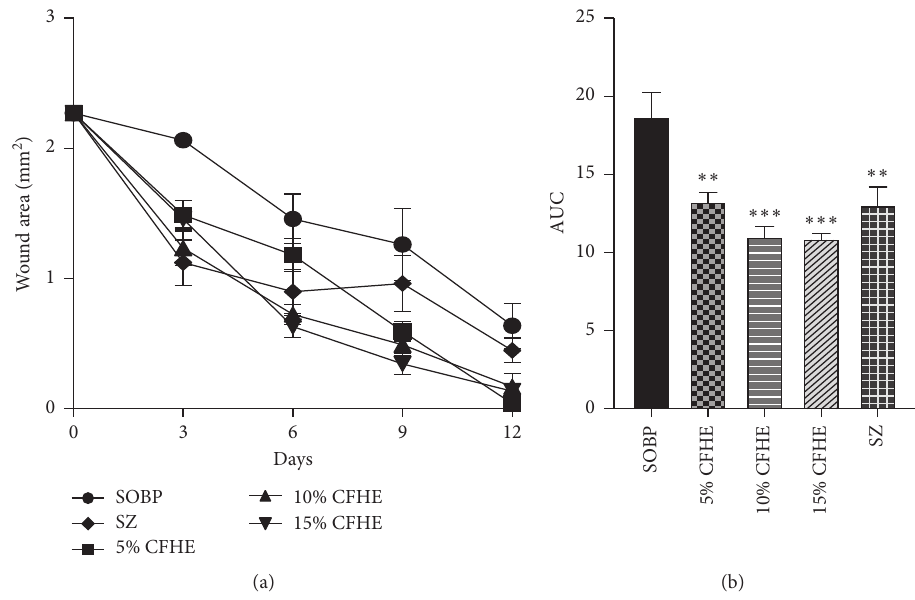
Figure 1: Effects of various concentrations of CFHE ointment, silverzine, and simple ointment BP on wound area in Albino rats. (a) Curves for time course of treatment, and (b) area under curve (AUC) of time-course curve. Values plotted are mean ± SEM, n � 5. ∗∗∗ p ≤ 0 . 001; ∗∗ p ≤ 0 . 001; treatment groups compared to control group (one-way ANOVA followed by Dunnett’s multiple comparisons test).